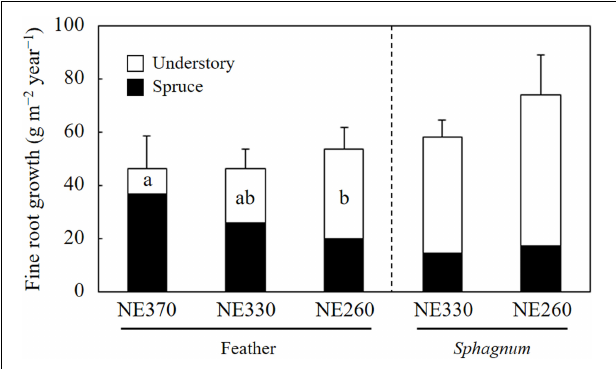
FIGURE 3 | Fine root growth rates of black spruce and understory plants in feather or Sphagnum -moss substrates at NE360, NE330, and NE260 plots. Black and white columns represent data on black spruce and understory plants, respectively. Data shown are mean + SE ( N = 9). Different alphabetical letters represent significant difference between the plots within each species category in each moss substrate (Tukey–Kramer HSD test). No letter was given when significant variation was not detected among the plots by one-way